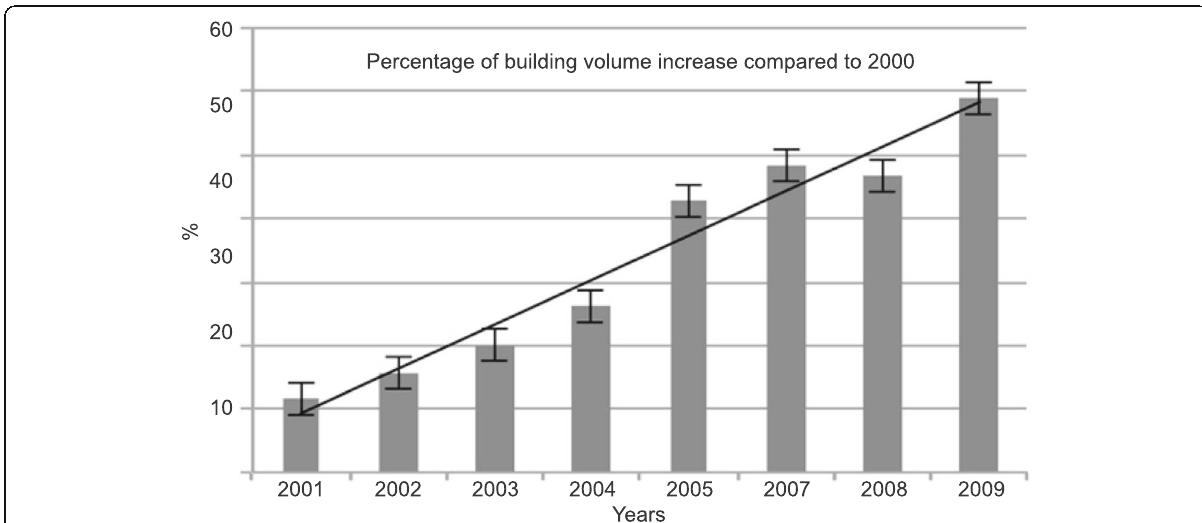
Fig. 17 Dramatic increase in the total building volume corresponding to the real estate boom since 2000 in an area of ~ 6 km 2 centered in the urban extent of Almaty in 2009 seen in red in the right panel of Fig. 16. Error bars show the accuracy of regional averaged values (columns) and incorporate together errors of the observation and area-averaging methods used. The linear trend line indicates the mean rate of the building volume increase during the study period and its comparison with error bars shows that the changes are clearly seen beyond the noise generated by observations and the averaging